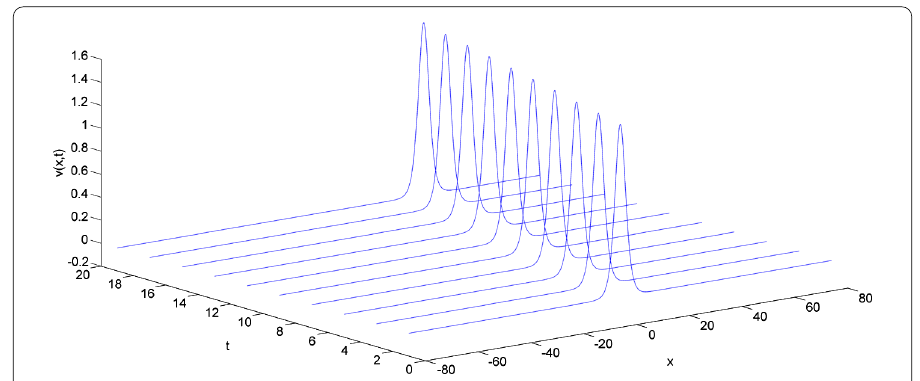
Figure 1 The propagation of one solitary wave